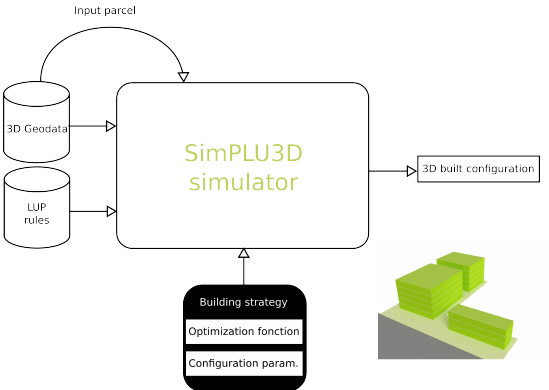
Figure 3. Built configuration generation with SimPLU3D.